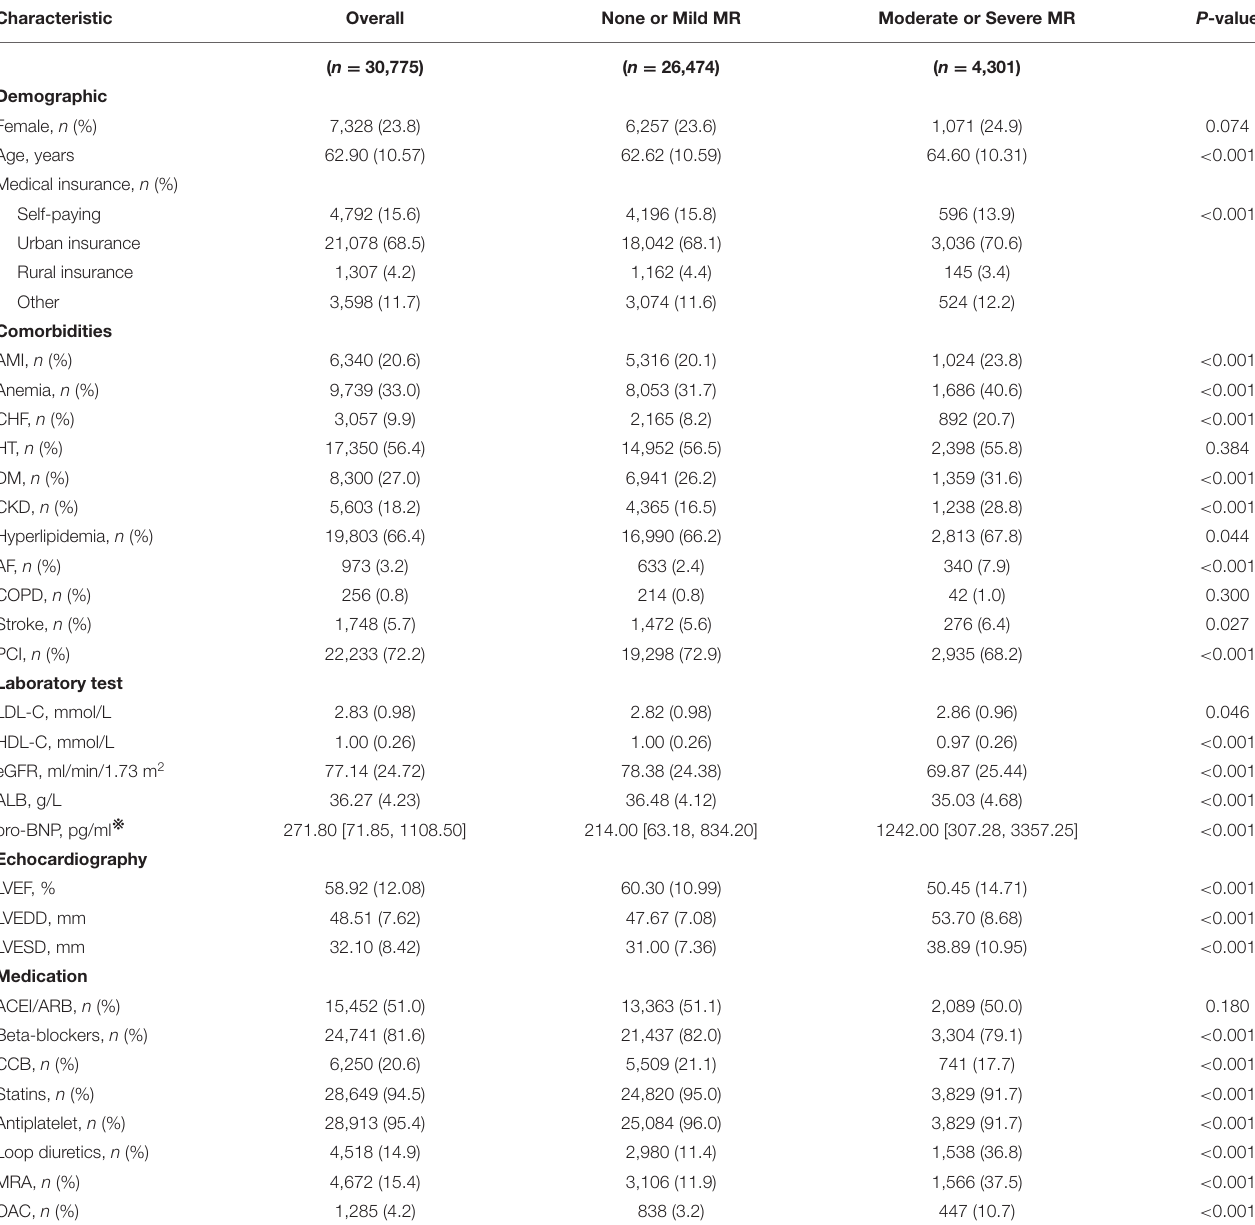
TABLE 1 | Baseline characteristics according to categories of mitral regurgitation (MR).